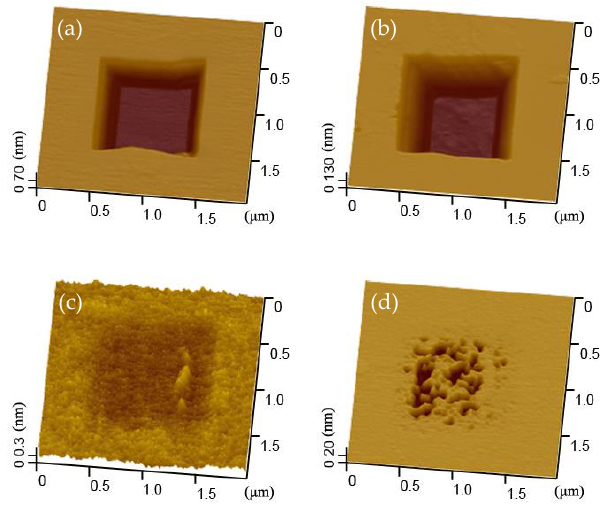
Figure 3. AFM images of wear scars on silicon surface after different etching time at 60%RH and 90%RH. F n = 3 μN, N = 2, A = 1 μm × 1 μm, v = 4 μm/s, ω KOH = 10%. ( a ) Etching for 8 min after the wear test at 60% RH; ( b ) Etching for 16 min after the wear test at 60% RH; ( c ) Etching for 8 min after the wear test at 90% RH; ( d ) Etching for 16 min after the wear test at 90% RH.